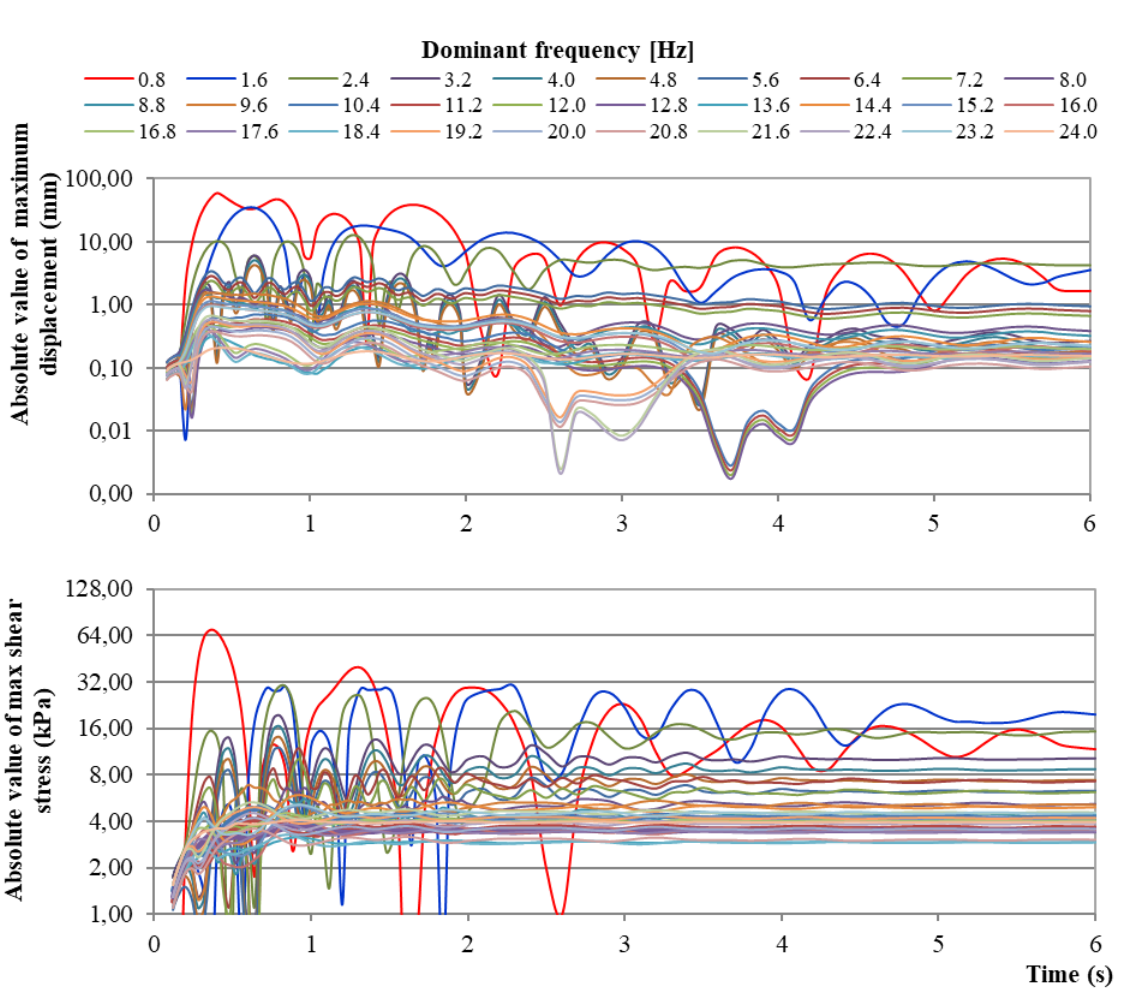
Figure 8: The calculated absolute values of displacement (top) and shear stress (down) changes at the base of the analysed slope depending on the used